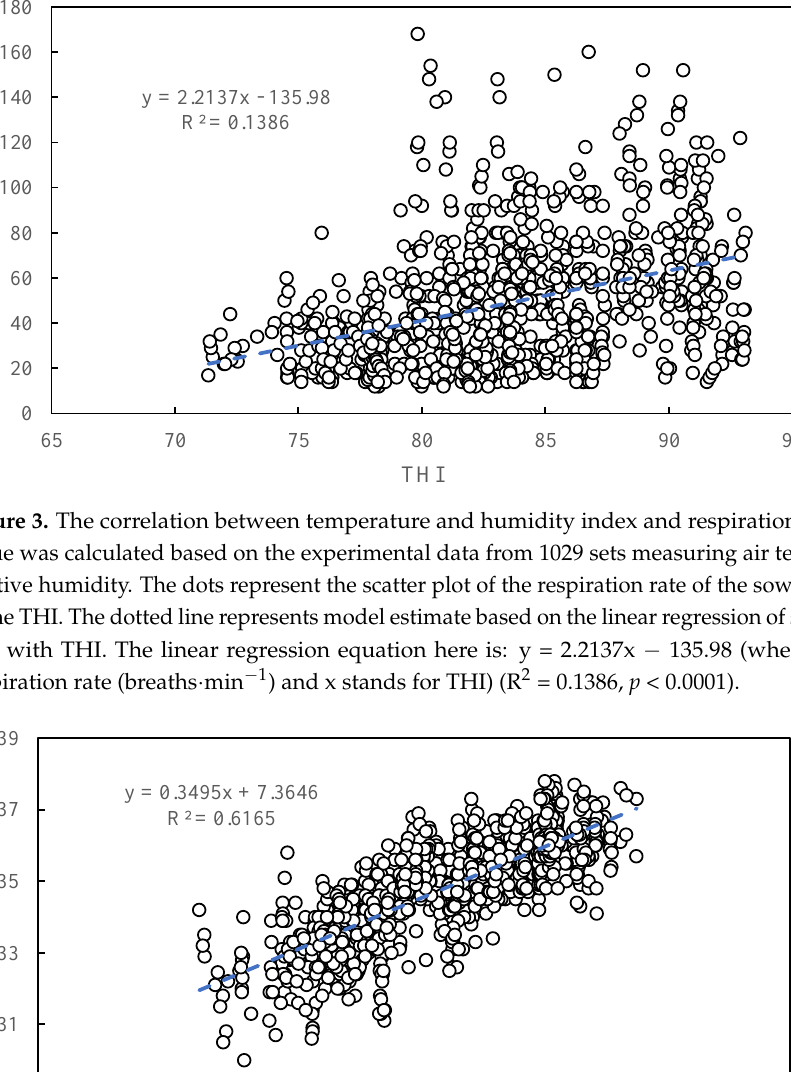
Figure 4. The correlation between temperature and humidity index and sow skin temperature. The